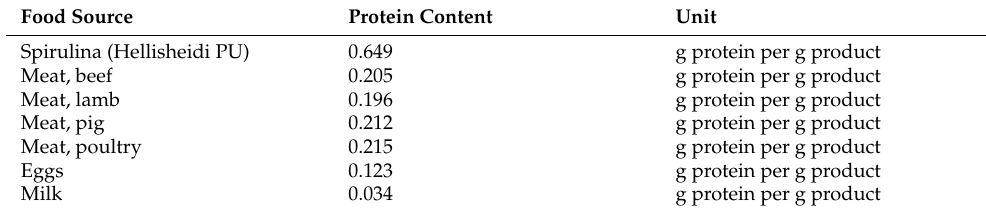
Table 2. Protein content of Spirulina and selected animal source foods (ASF). Values for ASF in this table are obtained from National Food Institute, Technical University of Denmark [84]. Food Source Protein Content Unit Spirulina (Hellisheidi